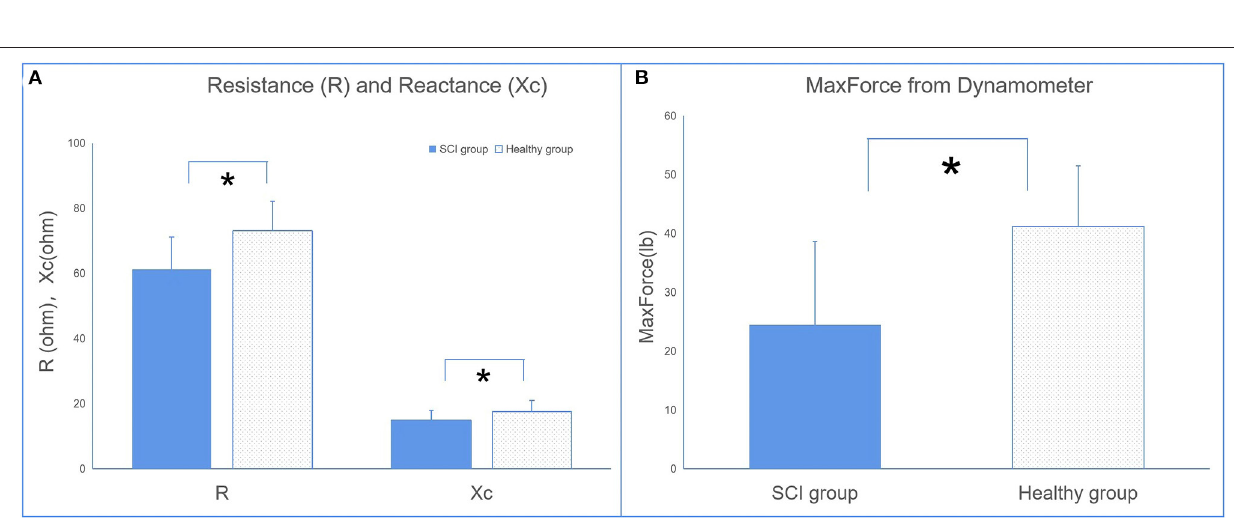
Frontiers in Neurology | www.frontiersin.org